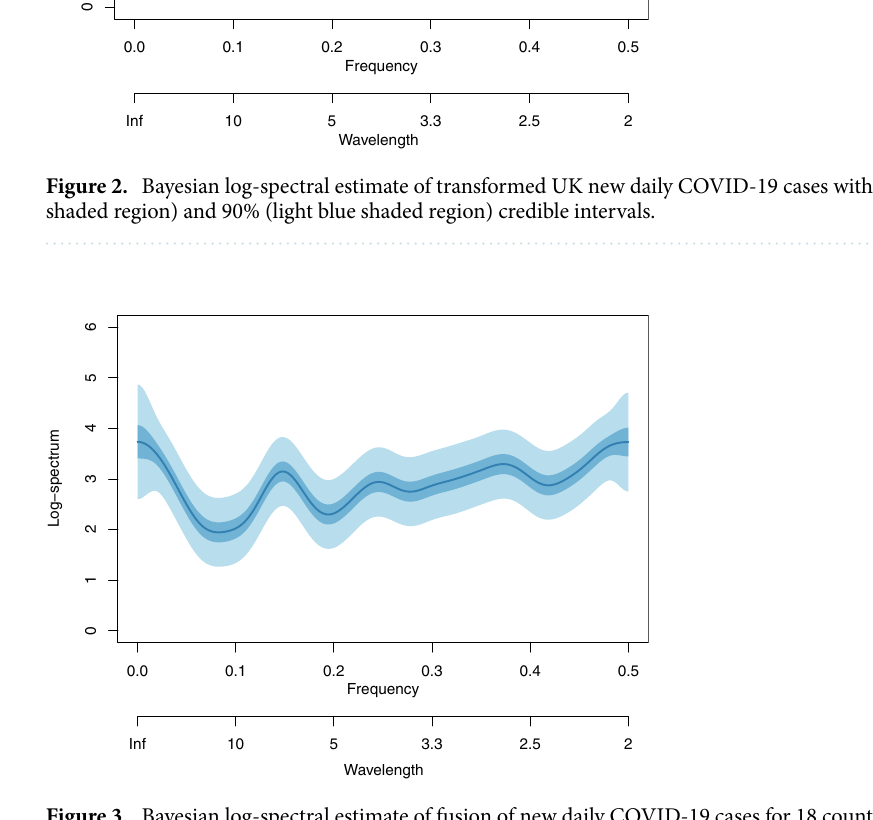
Figure 3. Bayesian log-spectral estimate of fusion of new daily COVID-19 cases for 18 countries with 50% (dark blue) and 90% (light blue) credible intervals. Countries included are the UK, Italy, France,